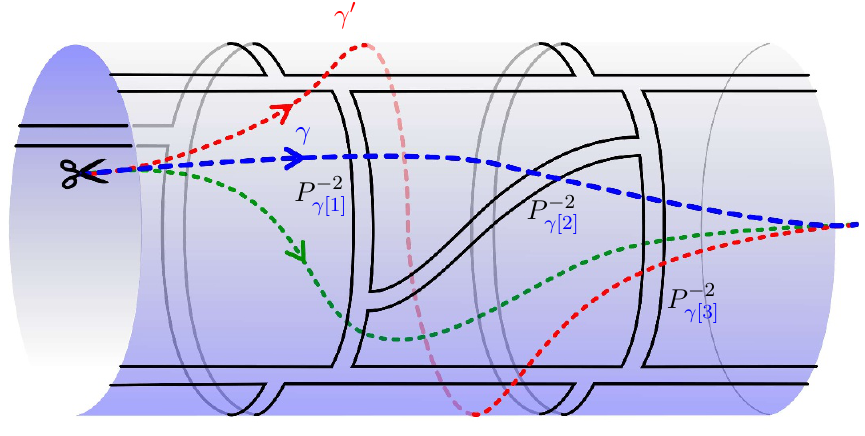
Figure 1 . A Feynman diagram that contributes to the double trace partial amplitude A 3 ; 2 . The dashed lines indicate its various cylinder cuts, which correspond to the diagram with (cid:12)xed momenta (cid:13)owing around the cylinder, l . The red dashed line wraps around the cylinder once more than the blue one, which implies that the cylinder cut momenta, l , is only de(cid:12)ned modulo a shift by the momentum (cid:13)owing through the cylinder, l ’ l + q